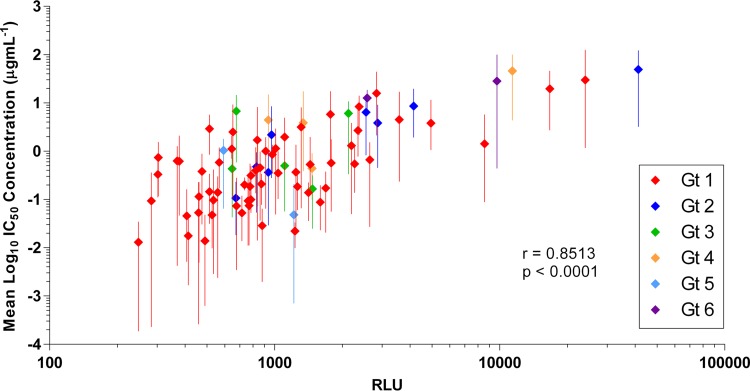
HCVpp infectivity conferred by E1E2 clones is correlated with its resistance to antibody neutralization. The mean uninhibited infectivity (RLU value), and the range, for each of the 81 E1E2 clones supplementing HCVpp was plotted against the mean log10 IC50 neutralization titer. r = 0.8513; P < 0.0001.